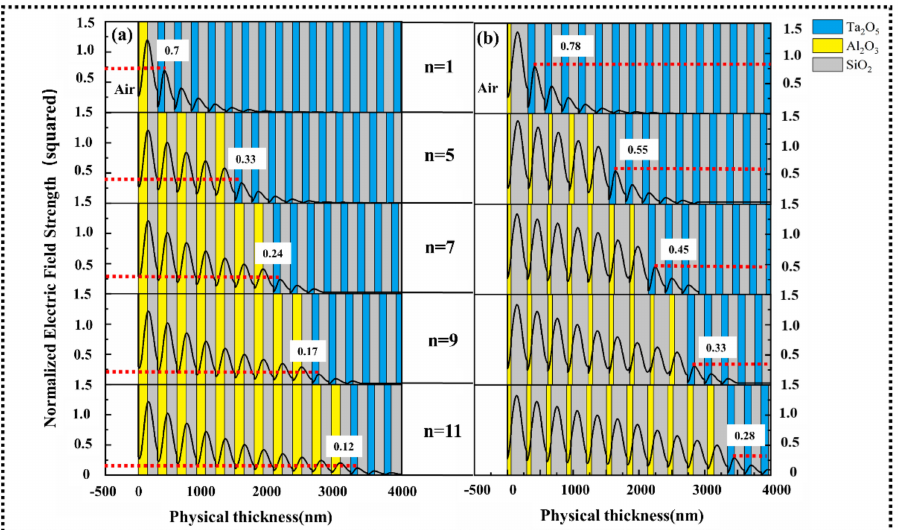
Figure 1. Calculated electric field distribution for different numbers of protective layer periods. ( a ) The electric field of a composite low-dispersion mirror (CLDM) for different numbers of protective layer periods. As the number of Al 2 O 3 periods increases, the electric field in the narrow-bandgap material decreases. Meanwhile, the peak electric field intensity in Al 2 O 3 remains constant. ( b ) The electric field of E-CLDM for different numbers of protective layer periods.